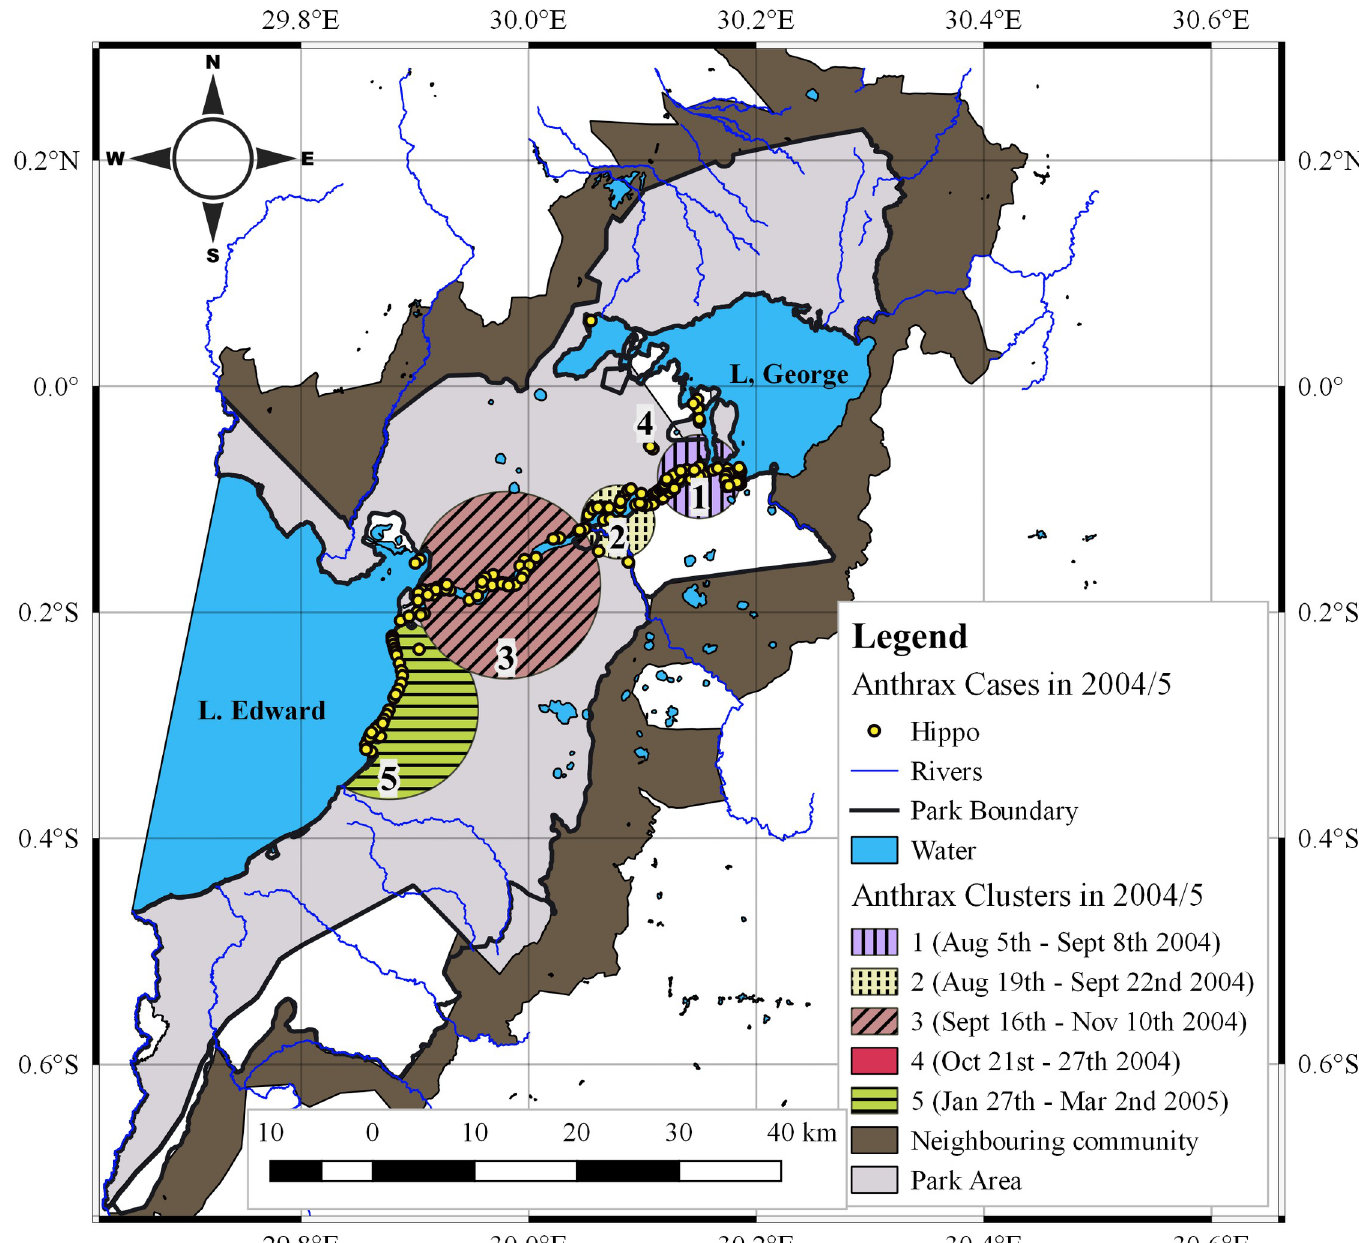
Fig 3. Spatial and temporal distribution of Hippopotamus anthrax clusters in 2004/5. Spatio-temporal data for clusters including centroid coordinates, radii, and time span were generated using the retrospective space-time permutation model of the spatial scan statistics and mapped using QGIS (Version 2.18.9). The first two clusters 1 & 2 had overlapping dates and were considered origins for this